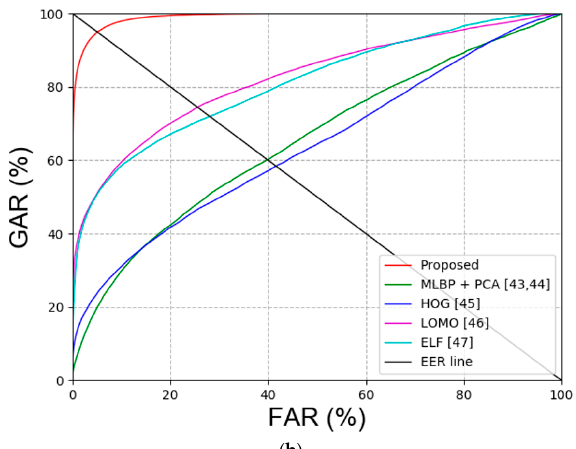
Figure 16. ROC curves for proposed and the state-of-art-method on ChokePoint dataset. ( a ) Face image results and ( b ) face and body image results.